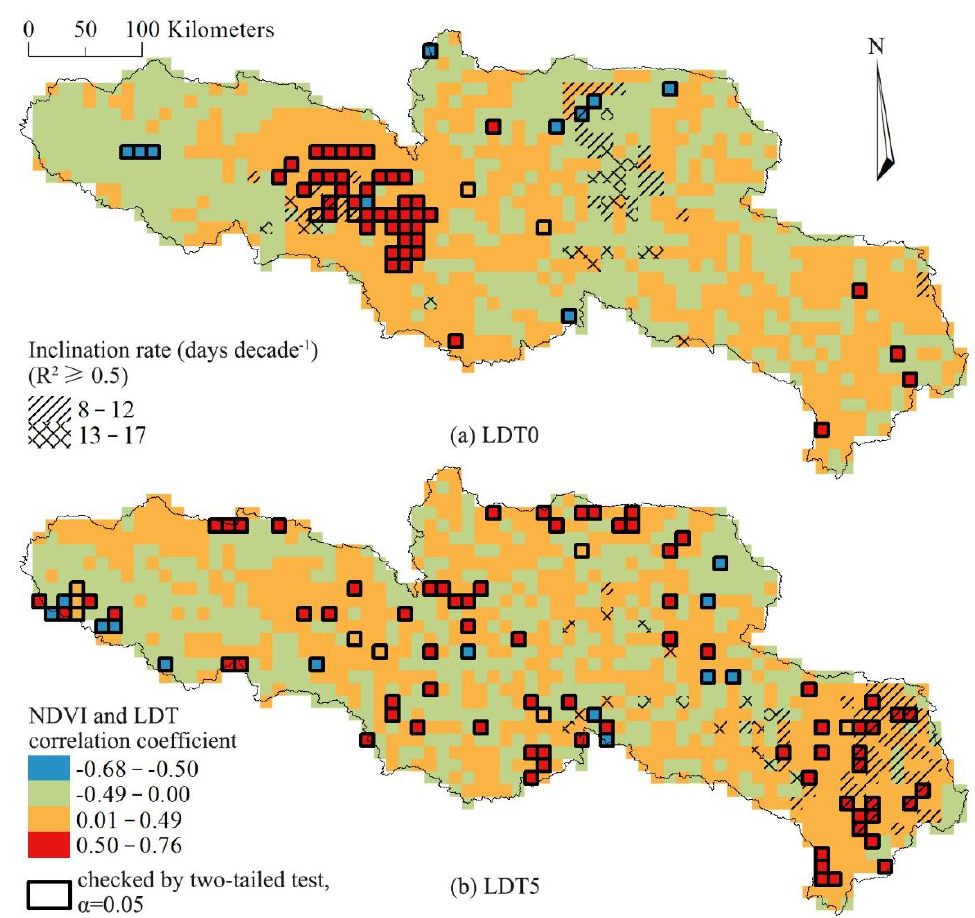
Figure 12. The Pearson correlation coefficient between annual maximum NDVI and lasting days of ≥ 0 ◦ C ( a ) and ≥ 5 ◦ C ( b ) annual accumulated temperature during 2001–2016, checked by two-tailed test, α = 0.05, and inclination rate of respective LDT with the determination coefficient R 2 of regression analysis ≥ 0.5 during 1998–2018 in the source region of the Yellow River.